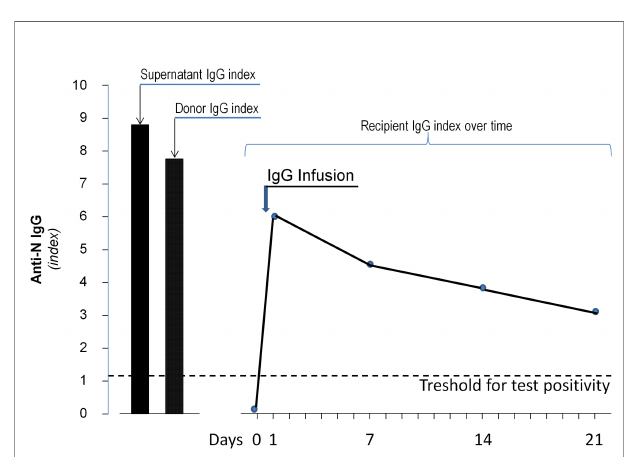
FIGURE 2 | Levels of anti-SARS-CoV-2 N IgG antibodies in the concentrate antibody solution infused to the patient, in antibody donor serum and in recipient sera collected before antibody infusion (day 0) and 7, 14, and 22 days thereafter. The dashed line indicates the threshold for antibody positivity.